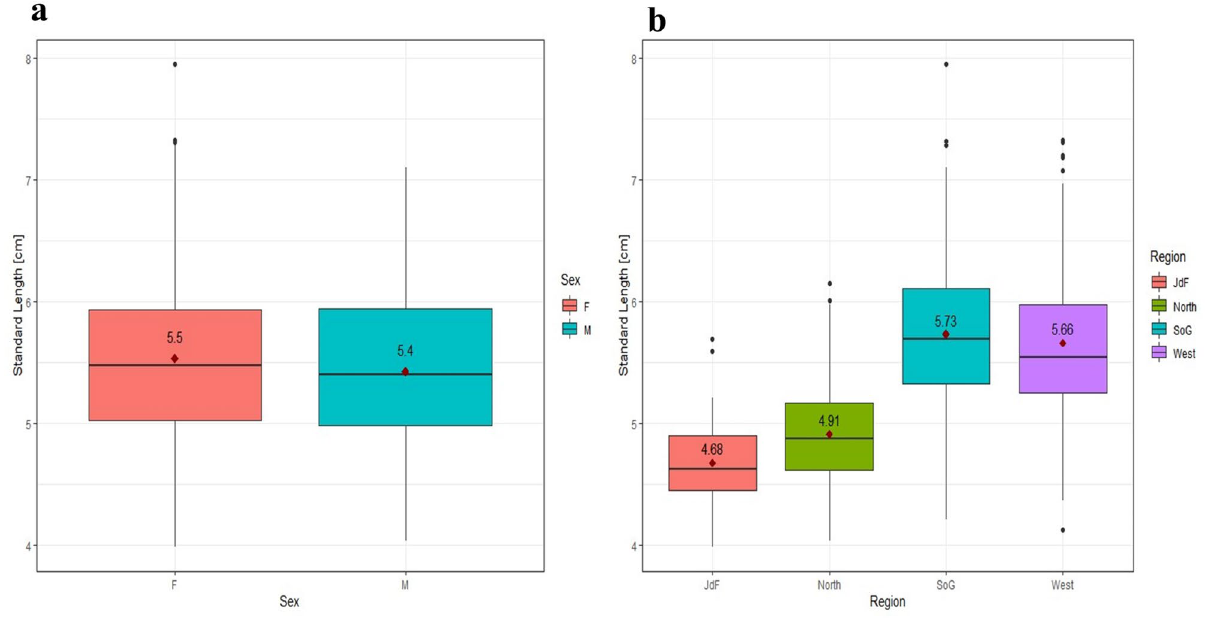
Figure 4. ( a ) Differences between male (M) and female (F) body size, represented by standard length (cm). ( b ) Regional variation between body size observed in four oceanographic regions. The regions include the Juan de Fuca Strait (JdF), the northern coast of Vancouver Island (North), Strait of Georgia (SoG), and the west coast of Vancouver Island (West). The solid black lines represent the median standard lengths. The red triangles represent the average standard length for each sex (with the average value in black above each point).